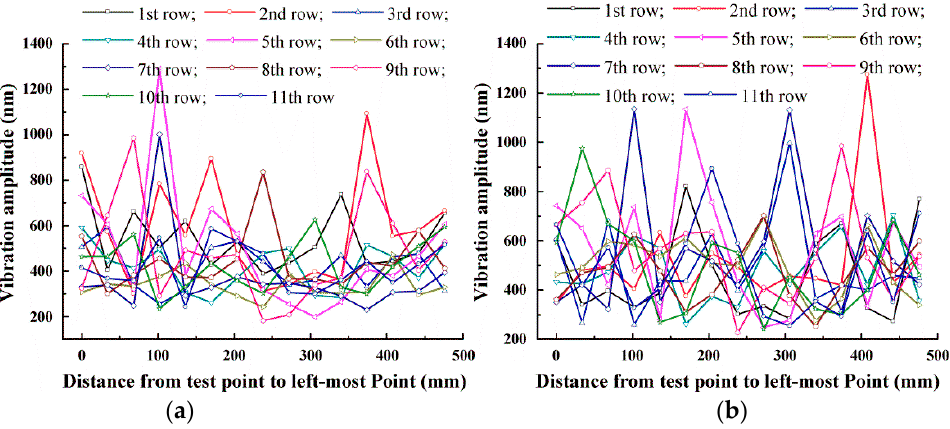
Figure 11. Vibration characteristics on the copper plate with different ultrasonic transducers opened. ( a ) Three ultrasonic transducers opened; ( b ) all ultrasonic transducers opened.